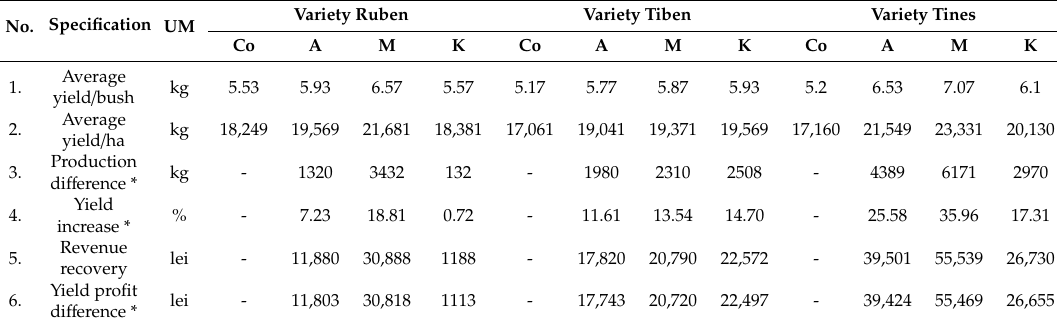
Table 9. Economic e ffi ciency indicators for the three blackcurrant varieties production under foliar fertilizers